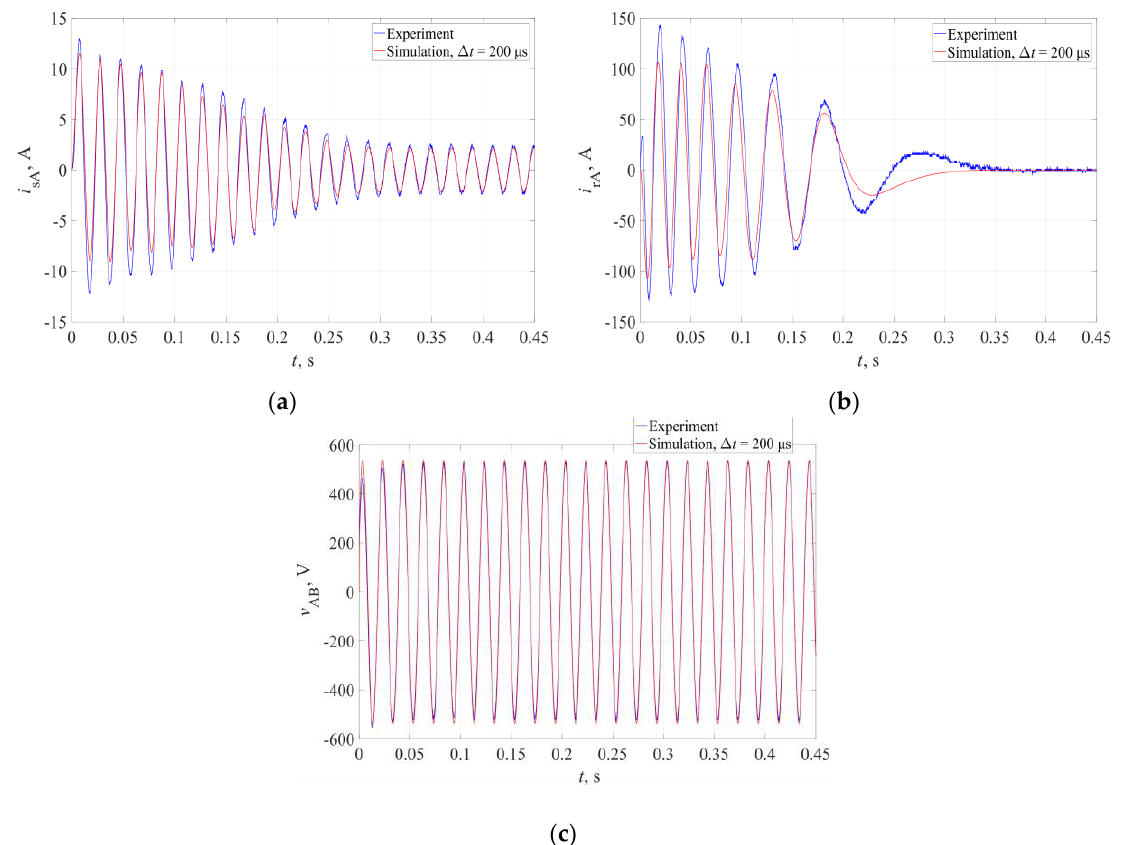
Figure 7. Waveforms of the stator current in the A phase ( a ), rotor current in the A phase ( b ) and phase-to-phase (A-B) voltage ( c ) at the stator winding terminals during start-up of the induction machine at idle operation (blue line = experiment, and red line = simulation with Δ t = 200 μ s).